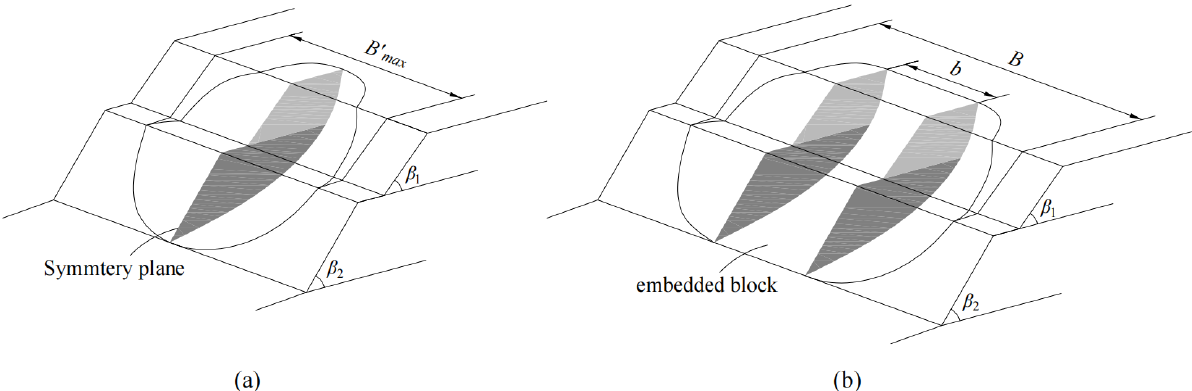
Figure 3. Stereoscopic diagram for 3D horn-like rotational mechanism: ( a ) without plane insert; ( b ) with plane insert.